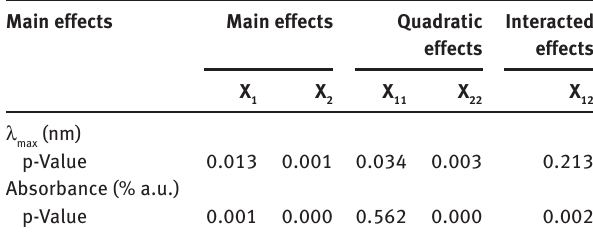
Table 3: p-Value of the regression coefficients in the obtained